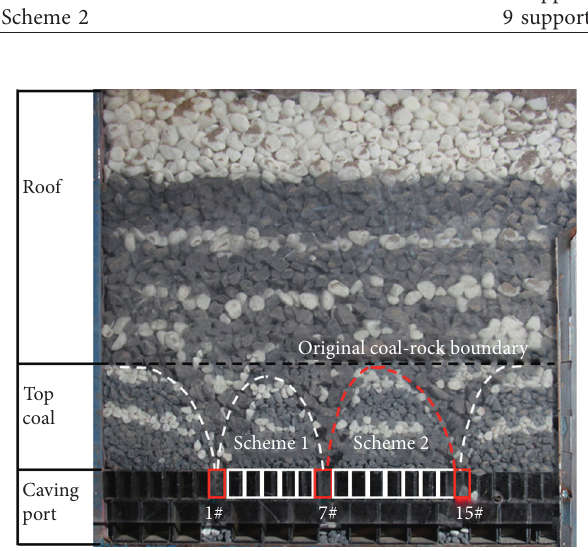
Figure 6: Coal-rock settlement curves for the two coal caving schemes (1#, 7#, and